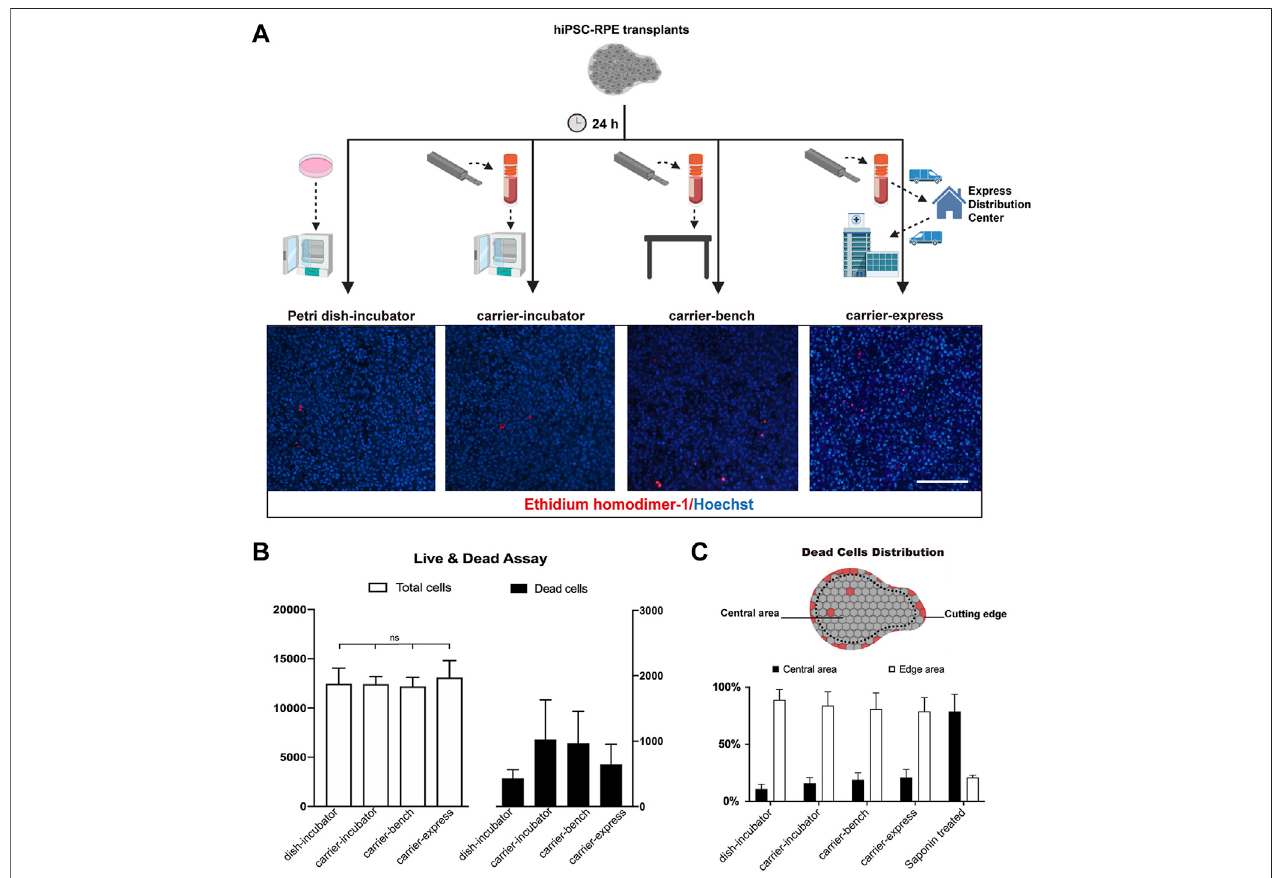
FIGURE 3 | Cell viability of hiPSC-RPE transplants stored in the carrier. (A) Work fl ow and representative pictures of live and dead cell viability assay in hiPSC-RPE transplants incubated for 24 h in Petri dish in a cell incubator (37 ° C, 5% CO 2 ; Petri dish-incubator group; control), carrier in a cell incubator (37 ° C, 5% CO 2 ; carrier- incubator group), at standard room conditions (25 ° C, 0.04% CO 2 ; carrier-bench group), and transported from the lab to the hospital by express shipping (10 – 23 ° C, 0.04%CO 2 ;carrier-expressgroup). (B) Totalcellnumber(whitebars)anddeadcellnumber(darkbars)incarrier-incubator,carrier-bench,carrier-expressandPetri dish-incubator groups. (C) Distribution of dead cells within hiPSC-RPE transplants among carrier-incubator group, carrier-bench group, carrier-express group, Petri dish-incubator group, and saponin-treated